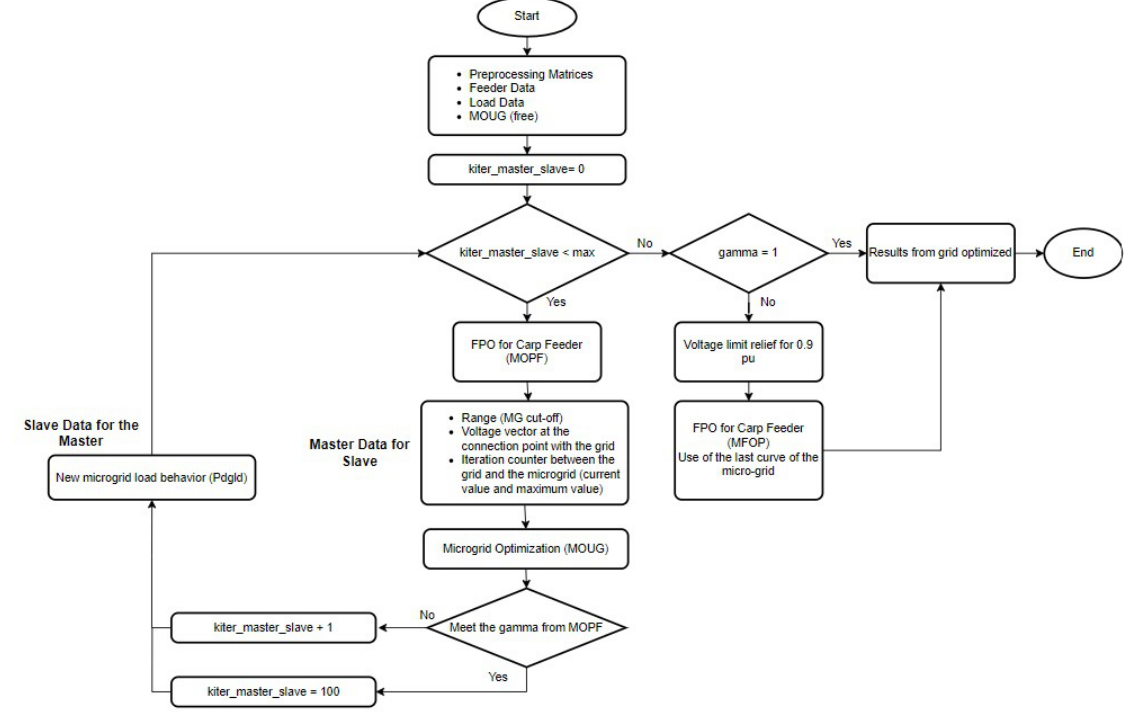
Figure 2. Flowchart of the proposed algorithm in the master–slave